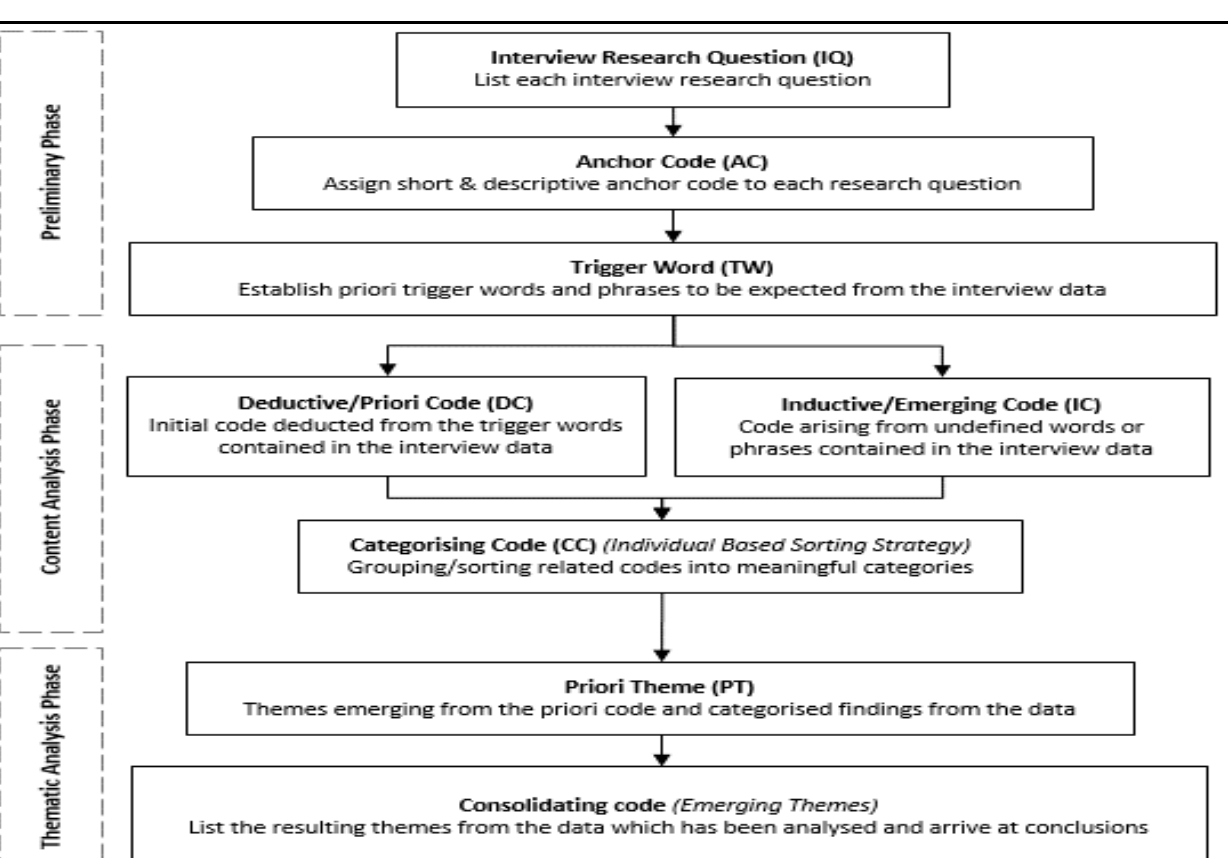
Figure 2. Data coding strategy (Adapted from Adu, [49]).